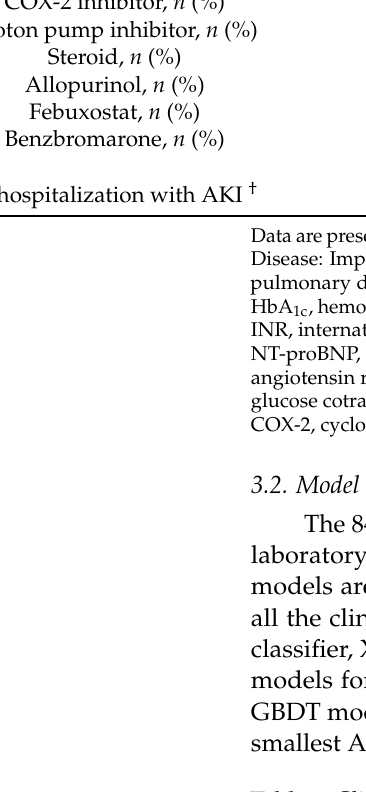
Table 2. Clinical features selected in machine learning